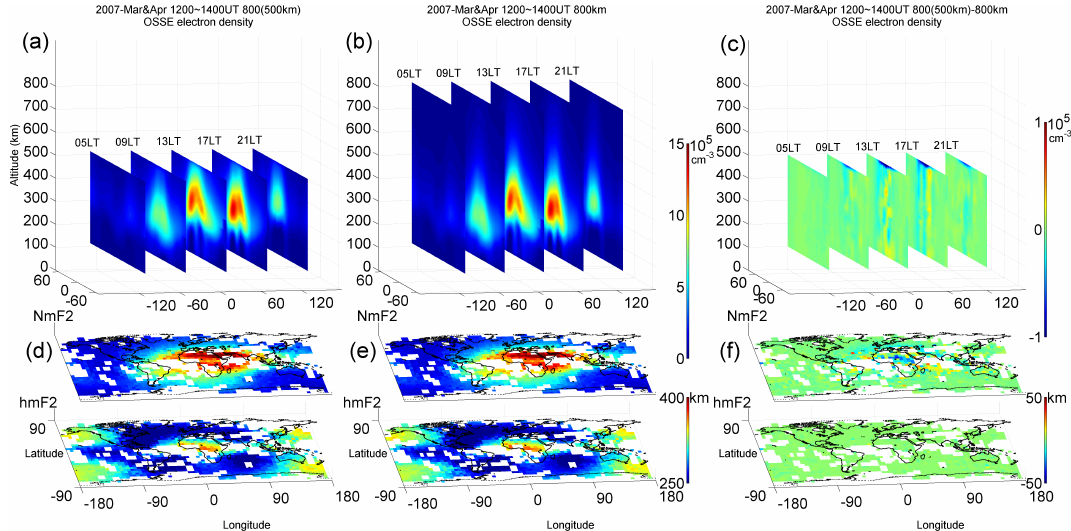
Figure 6. The Abel inversion OSSE electron density, Nm F2, and hm F2 observed from 500 and 800km altitude satellites, whose sounding geometries are identical, and their difference during 12:00–14:00UT in March and April of 2007. (a) OSSE electron density observed from 800 shifted to 500km altitude, (b) OSSE electron density observed from 800km altitude, and (c) their difference. (d) OSSE Nm F2 and hm F2 observed from 800 shifted to 500km altitude, (e) OSSE Nm F2 and hm F2 observed from 800km altitude, and (f) their